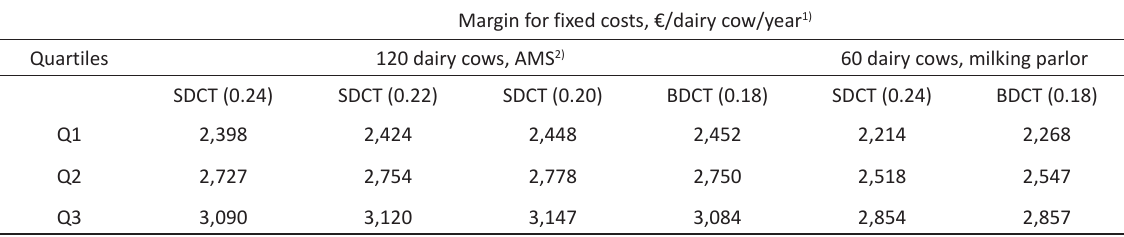
Table 2. Quartiles of annual margin for the fixed costs per dairy cow in herds implementing selective dry cow therapy (SDCT) and blanket dry cow therapy (BDCT) by herd size and milking system (probability of post-calving intramammary infection in parentheses). Margin for fixed costs, €/dairy cow/year 1)